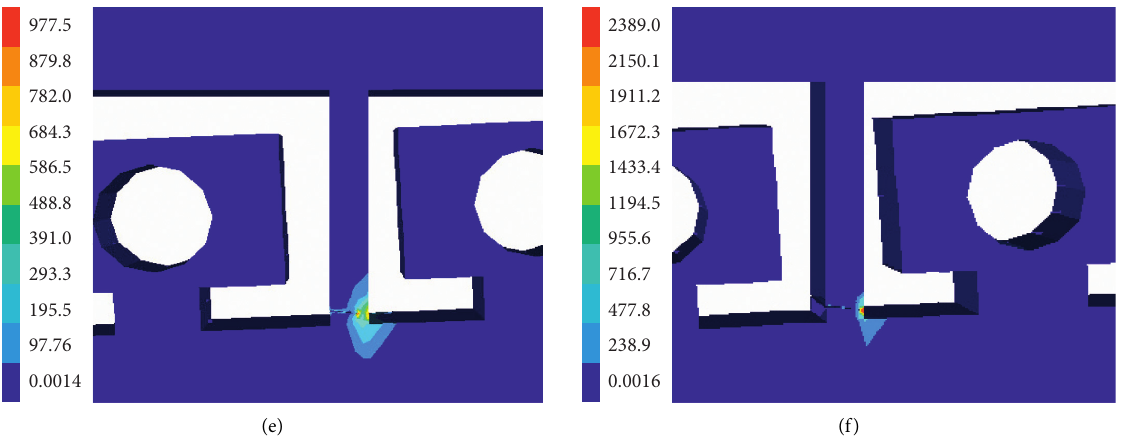
Figure 13: Mises stress distributions of the fixture with a unilateral crack. (a) 0.1mm. (b) 0.5 mm. (c) 1.0mm. (d) 1.5mm. (e) 2.0mm. (f) 2.5 mm.